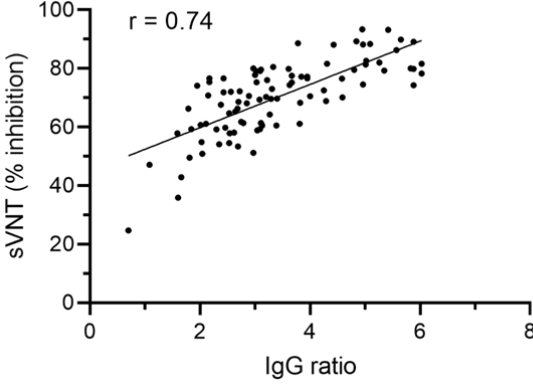
Figure 5. SARS-CoV-2 anti-S IgG ratio values correlate with in vitro antibody functionality. Spear- man correlation analysis of 92 different CP donations indicates a significant correlation between SARS-CoV-2 anti-S IgG ratio values and in vitro antibody functionality detected by a surrogate virus neutralization test (sVNT). Spearman’s r = 0.74, p < 0.001.